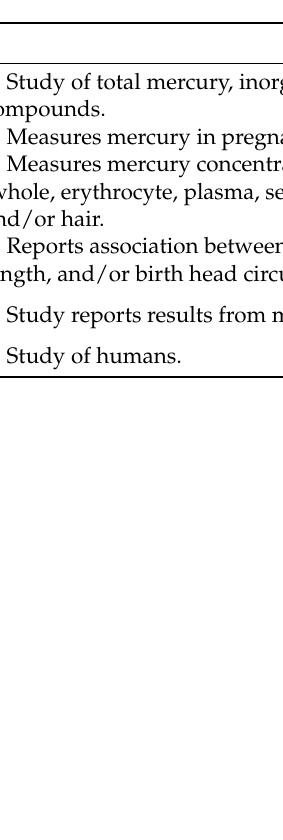
Table 1. Criteria for including or excluding papers from this systematic